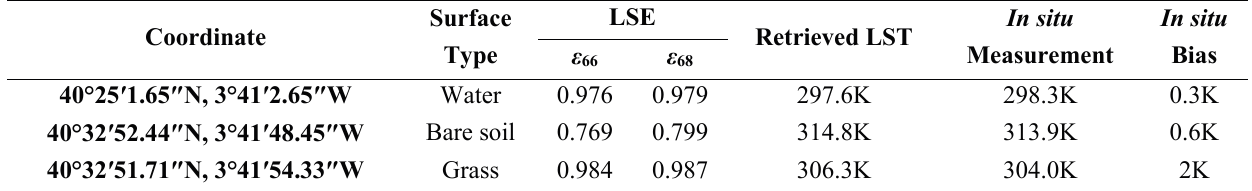
Table 4. Validation results over three areas.